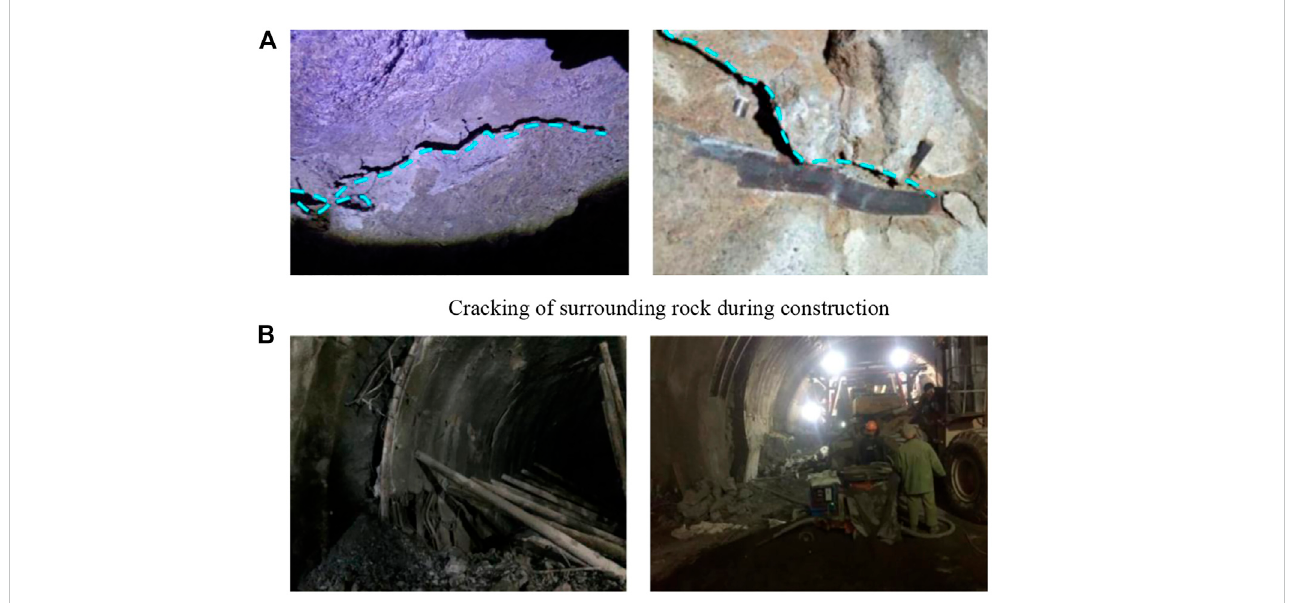
FIGURE 3 Large deformation and cracking ofsurroundingrock and initial support. (A) Cracking ofsurroundingrock during construction. (B) The large deformation of initial support in the arch shoulder and the left arch waist.